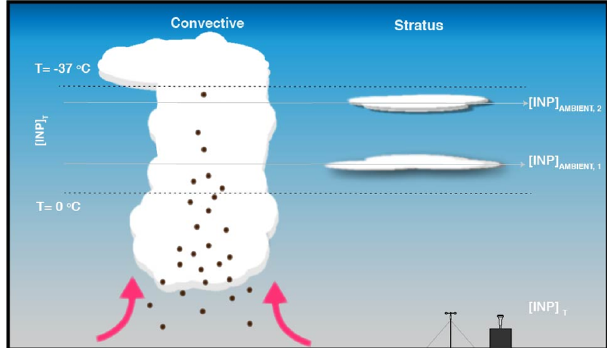
Figure 3. Illustration of the two ways in which we display INP con- centrations. It is important to bear in mind that INPs are defined as particles with the potential to nucleate ice and their concentration is quoted for a specific set of conditions. [INP] ambient , where ambient denotes the local atmospheric temperature, is a useful way of look- ing at the INP concentration relevant to non-deep convective mixed- phase clouds. [INP] T , on the other hand, has utility in representing the spectrum of INP concentrations over temperature that will in- fluence clouds with a large vertical extent such as deep-convective systems. Moreover [INP] T is the relevant quantity when comparing modelled and observed INP concentrations, since measurements are made by exposing particles to controlled temperatures within the in-